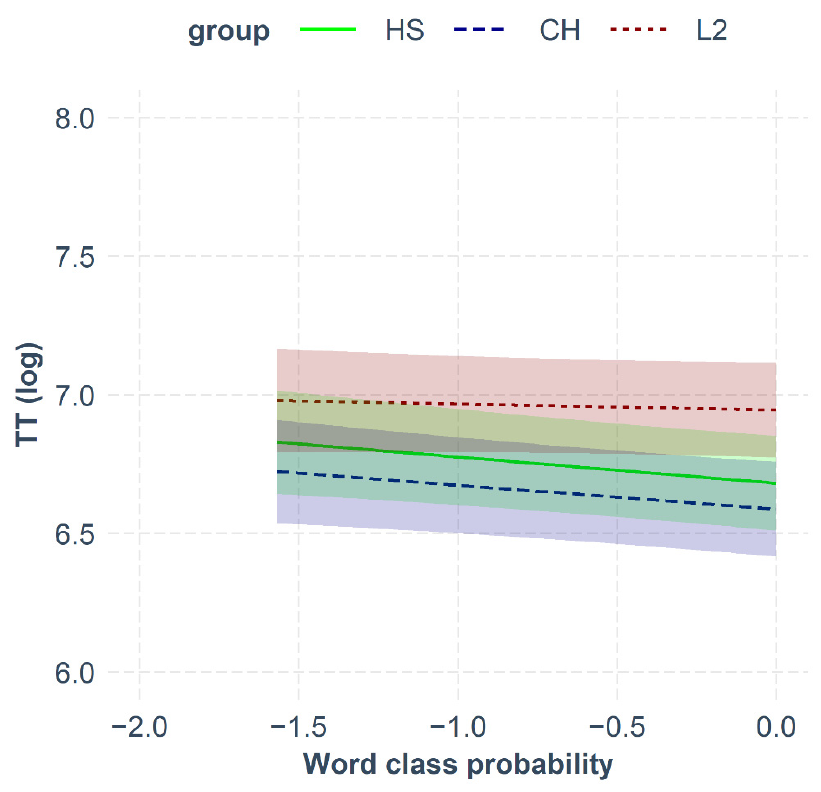
Figure 2. Interaction plot for the TT duration measure as a function of the word class probability.